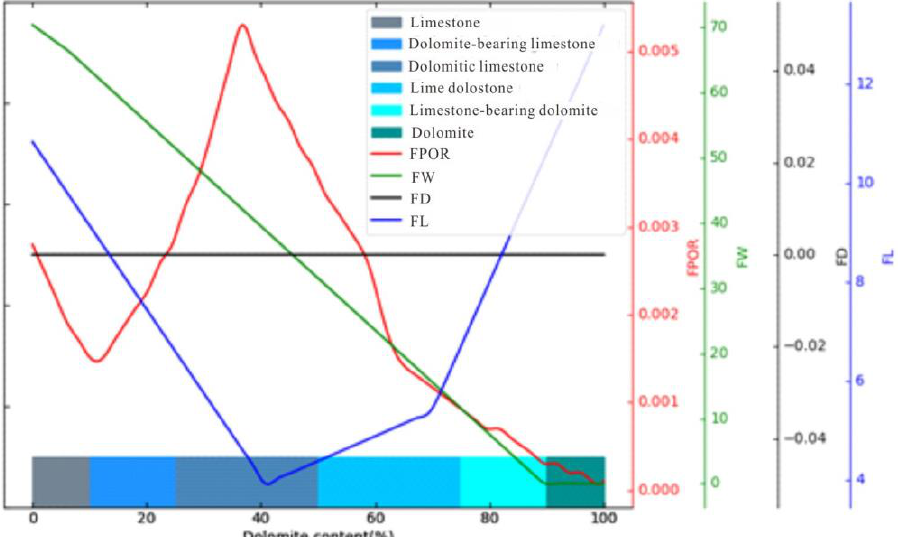
Figure 12. Development of fracture parameters with different dolomite contents in the absence of argillaceous content.